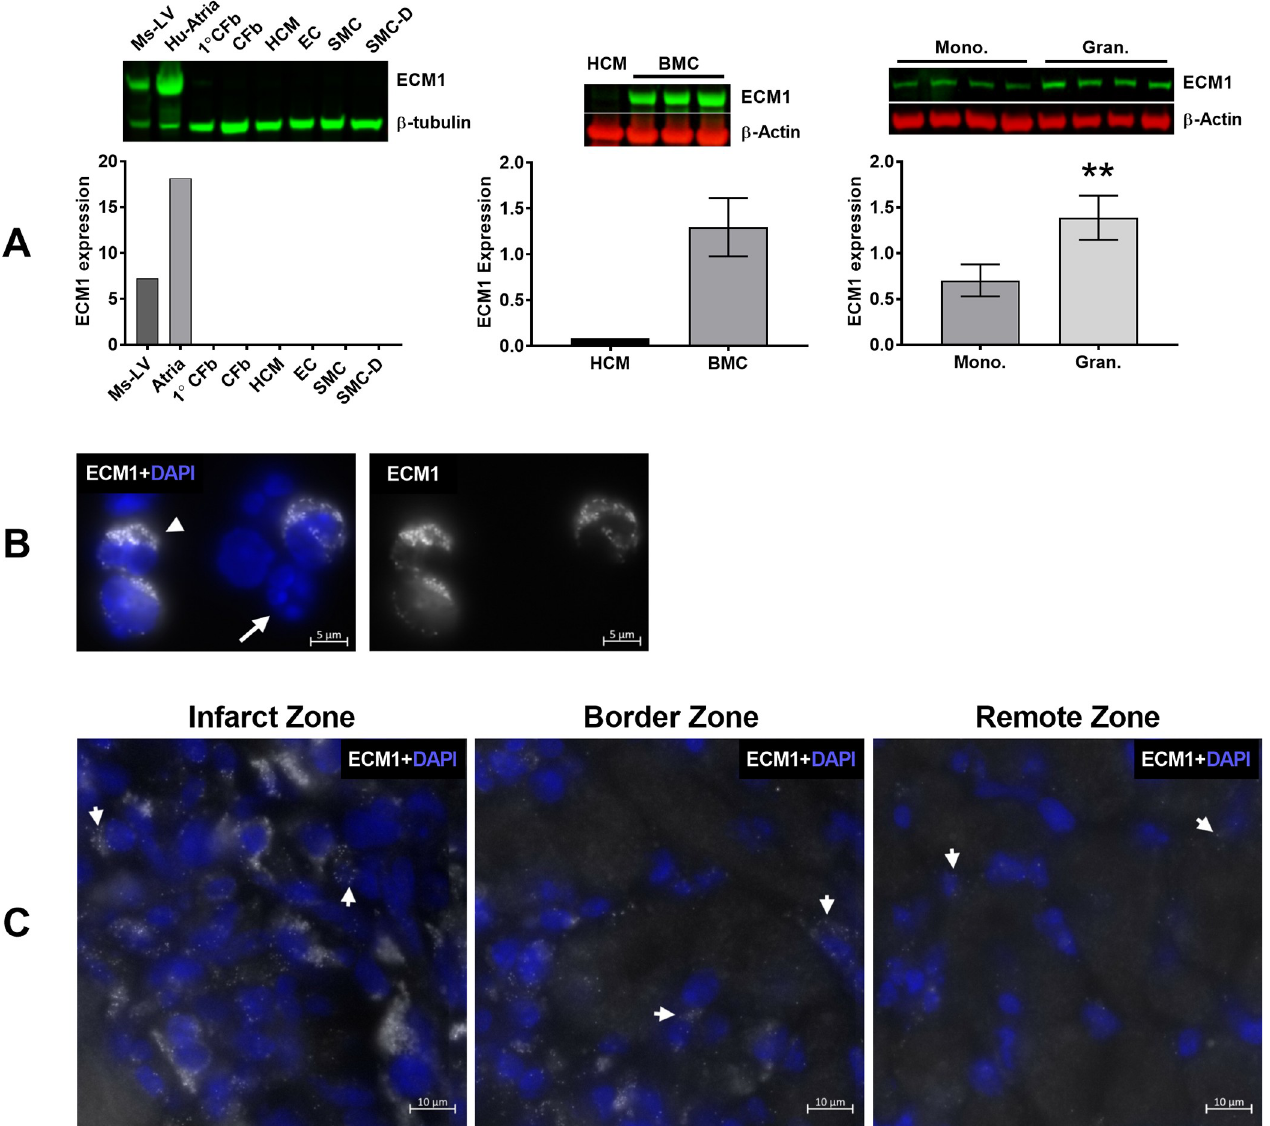
Fig 2. ECM1 is not expressed by resident cardiac cells, but is highly expressed in bone marrow cells (BMCs) and cells in the infarct zone day-3 post-MI. A) Immunoblot of ECM1 protein expression (~75kDa) in primary human CFbs, and cell lines: human CFb (CFb), human cardiac myocytes (HCM), human coronary artery EC (EC), SMC (SMC) and SMC differentiated (SMC-D) cell lines (Left). No ECM1 protein expression is seen in any cell type; positive controls show ECM1 expression in mouse LV (Ms-LV), and human atrial appendage (Hu-Atria), all data was normalized to β -tubulin expression as a loading control (~55kDa). Immunoblot of ECM1 protein expression in BMCs from young healthy mice (middle, n = 3, HCM serve as a negative control), and in BMCs separated into mononuclear and granulocyte fractions by Ficoll-Paque gradient density centrifugation (right, n = 4). A high level of ECM1 expression in BMCs, with a significantly higher level of ECM1 expression in granulocytes (gran.), compared to monocytes (mono., p = 0.005); all data was normalized to β -Actin expression as a loading control (~42kDa). B) mRNA-FISH of Ecm1 mRNA (white), conducted on BMCs in suspension; DAPI nuclear stain was used to visualize cell nuclei (Blue). ECM1 mRNA is expressed in some BMCs (arrowhead), and not in other BMCs (full-arrow). C) mRNA-FISH of ECM1 mRNA conducted on day-3 post-MI LV tissue, showing positive ECM1 expression as areas of sharp and punctate Cy5 fluorescent dots; example areas indicated by arrowheads, DAPI nuclear stain was used to visualize cell nuclei (Blue). High ECM1 mRNA expression is seen in the infarct zone, some expression in the border zone, and little expression in the remote zone, consistent with inflammatory cell infiltrate. In Fig 2A, positive controls and resident cardiac cells (right) n = 1 technical replicates/group, BMCs n = 3/group, BMC monocytes and granulocytes n = 4/group. �� p < 0.01 relative to